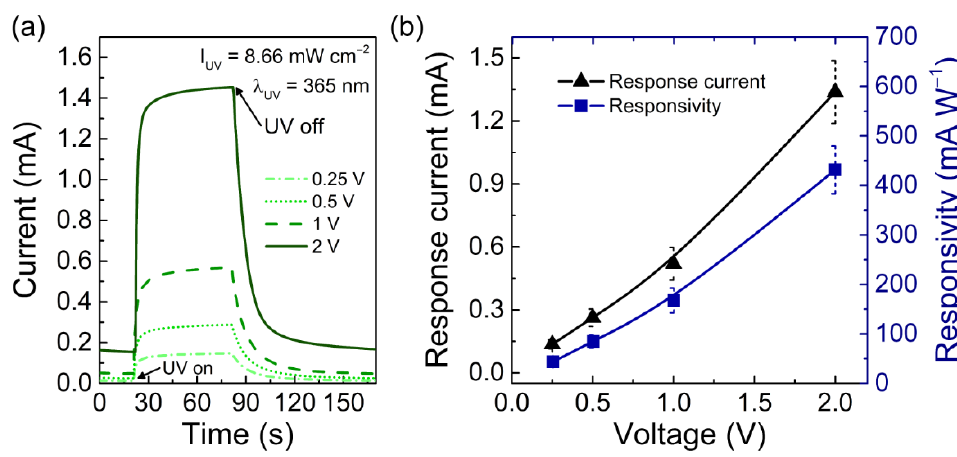
Figure 4. ( a ) Average photoresponse of the screen-printed CMC/ZnO UV sensor on office paper under different bias voltages for a UV light intensity of 8.66 mW cm − 2 . ( b ) Response current and respective responsivity for different applied voltages.